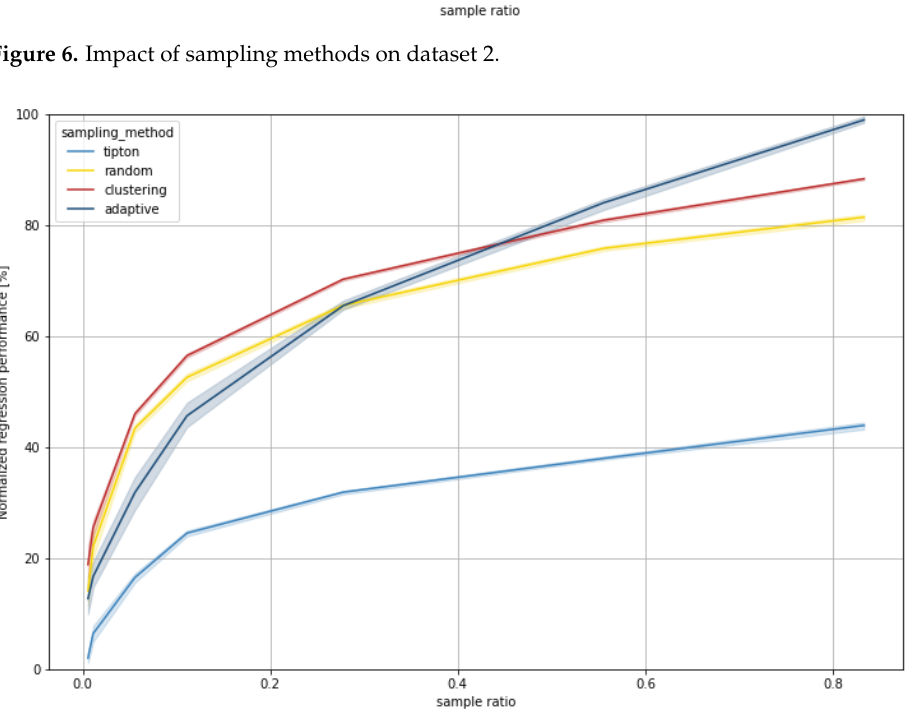
Figure 7. Impact of sampling methods on dataset 3.